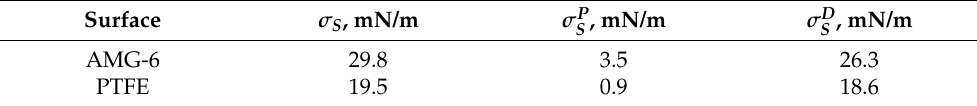
Table 2. Surface free energy and its polar and dispersive parts for AMG-6 and PTFE.